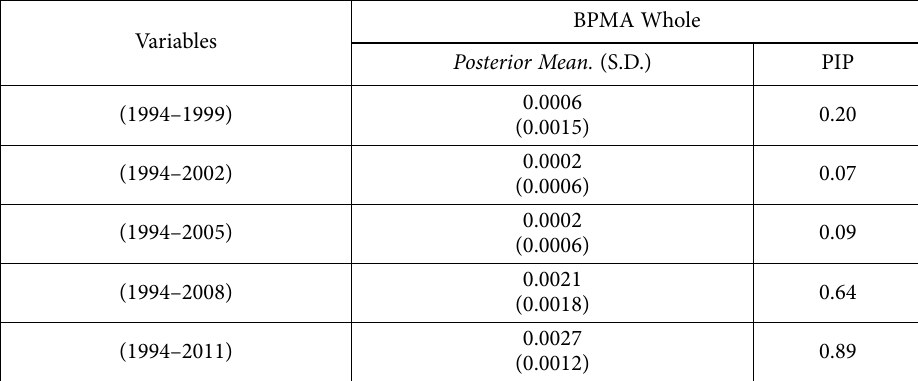
Table 3. BPMA Estimates for internet coefficient ( D iT –0 ) for the different period considered, correcting endogeneity Variables